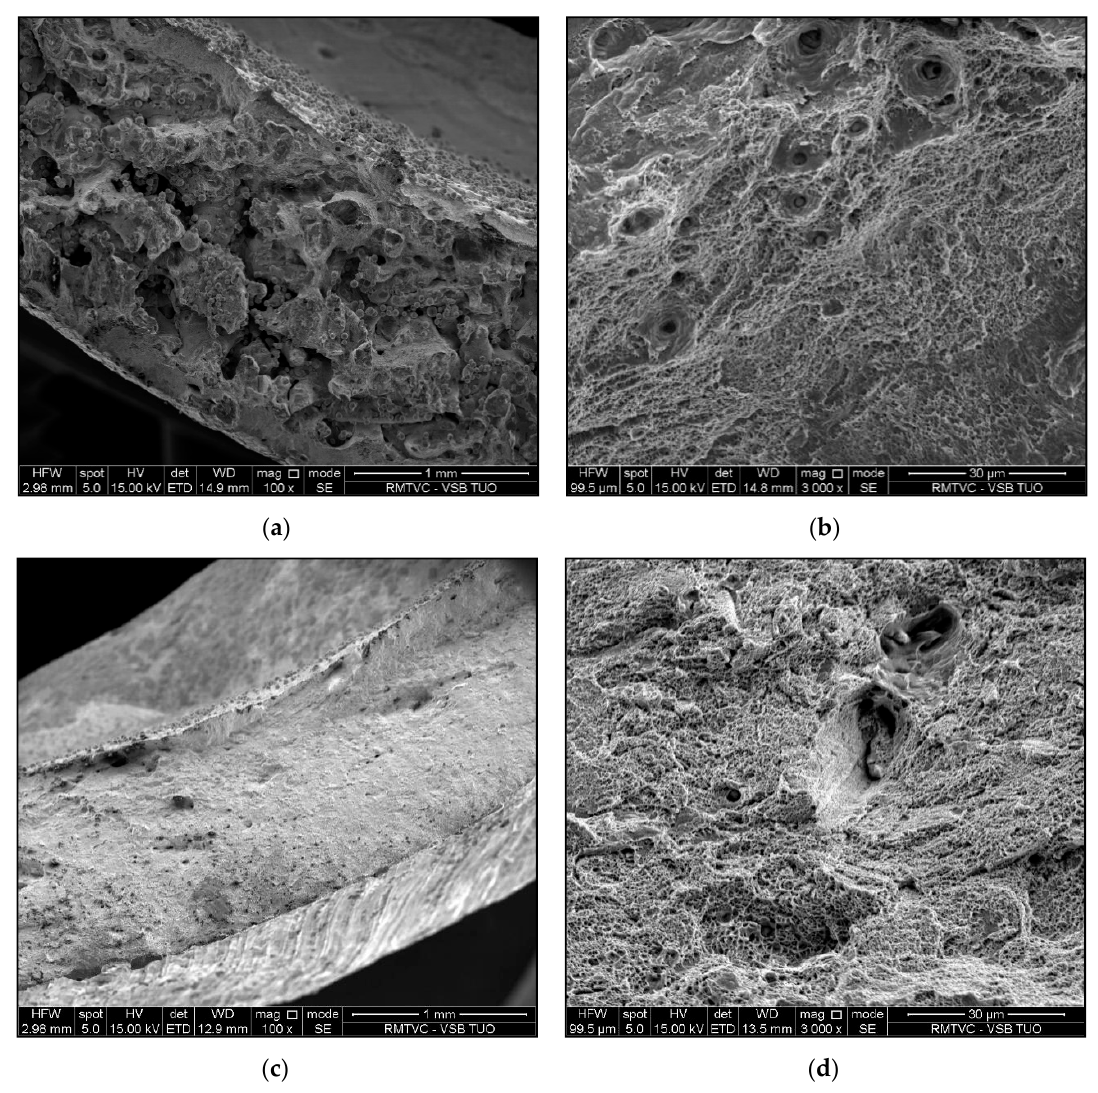
Figure 14. ( a ) Fracture surface of sample No. 5; ( b ) Detail of ridges on the fracture surface, sample No. 5, transcrystalline ductile fracture; ( c ) Fracture surface of sample No. 6; ( d ) Details of fracture surface in the middle of the sample, sample No. 6, transcrystalline ductile fracture and pores.